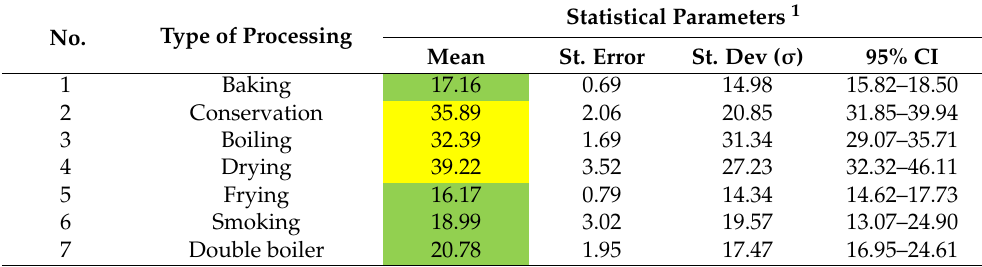
Table 2. ARP values predicted for products processed by different methods.